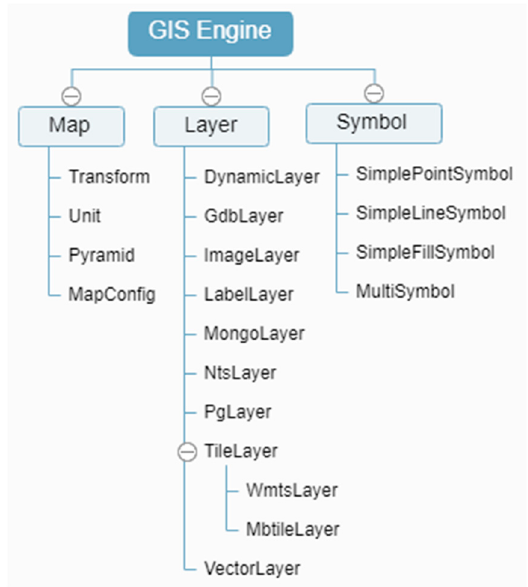
Figure 4. Geographic information system (GIS) engine structure. The name of the GIS engine is imagetile, which was derived from the research results of an actual project. By continuously accumulating support for different data sources and correcting the coordinate and symbol systems, a complete GIS kernel is formed.